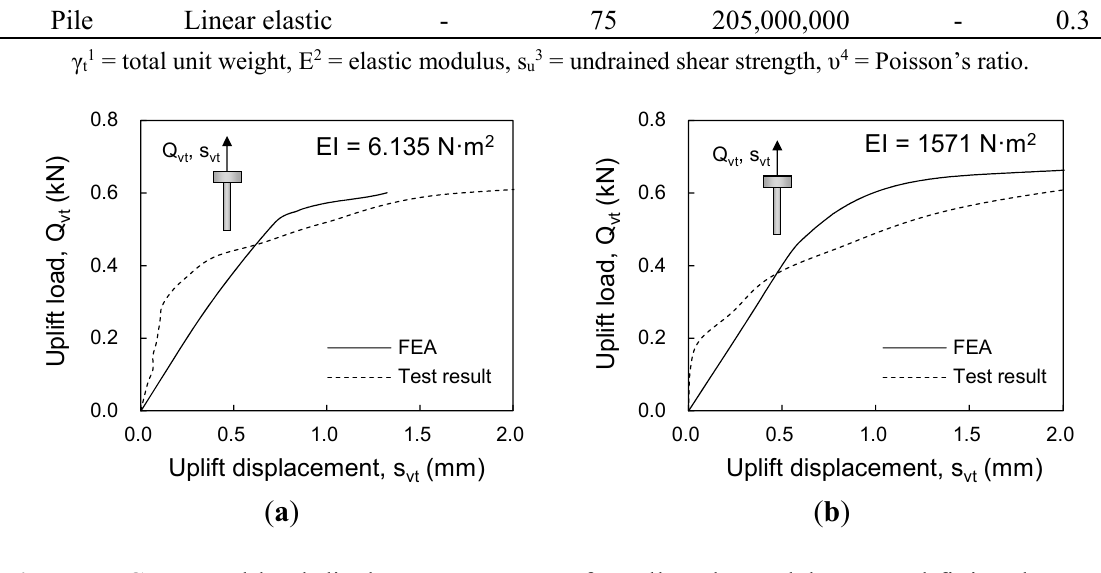
Figure 7. Compared load-displacement curves of small-scale model tests and finite element analyses for connection beam cases of ( a ) EI = 6.135 N·m 2 and ( b ) EI = 1571 N·m 2